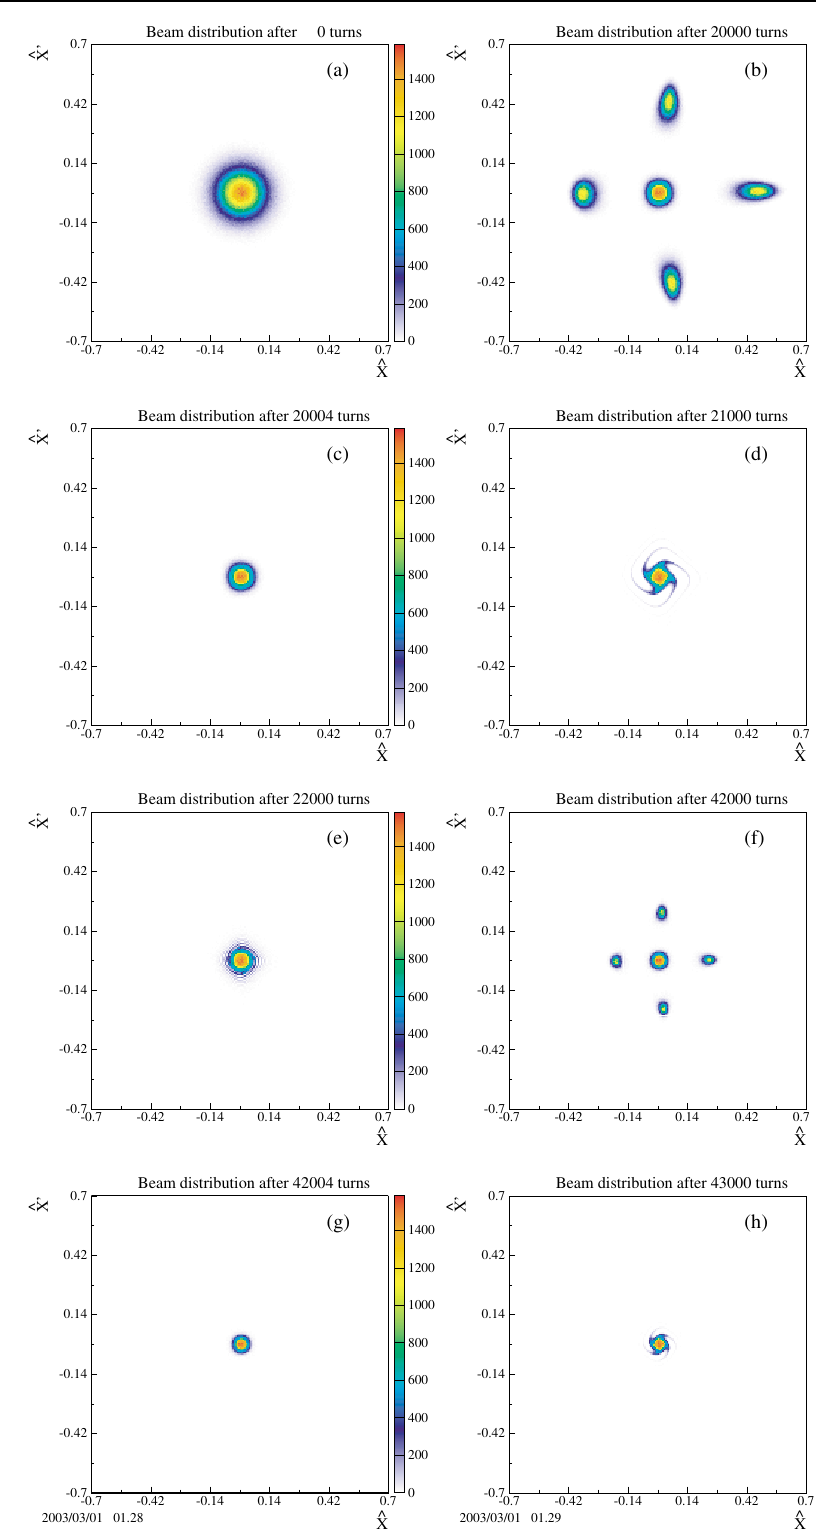
FIG. 12. (Color) Beam distribution during the multiple multiturn extraction for the fourth-order resonance ( 8 : 1 (cid:9) 10 5 initial conditions). The initial distribution is a Gaussian centered on zero, with standard deviation (cid:21) (cid:1) 0 : 07 . The value of (cid:14) is changed according to the curve shown in Fig.